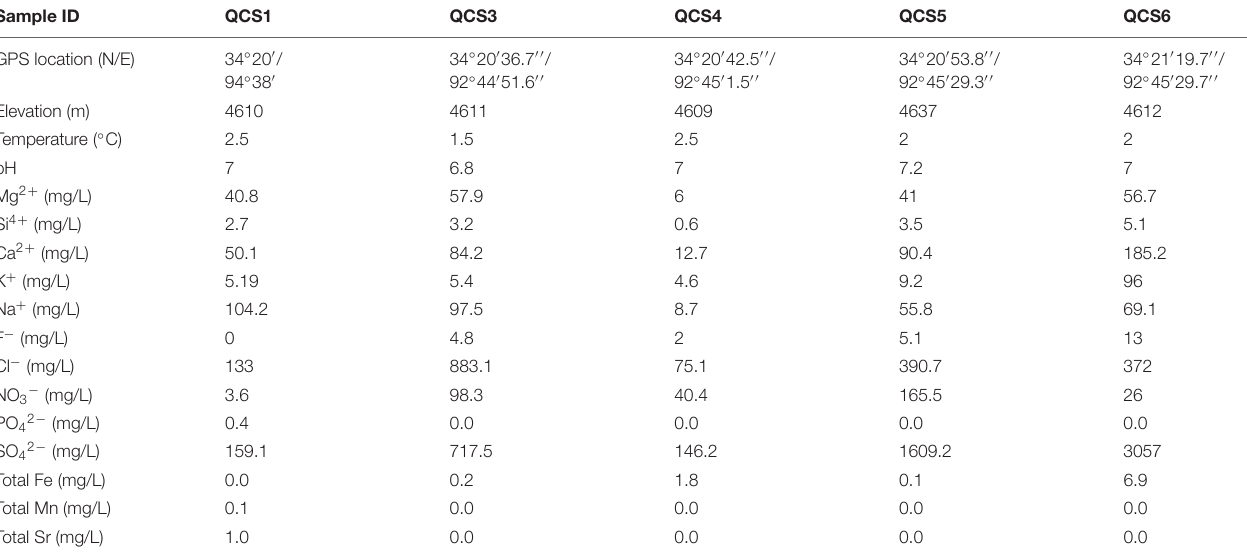
TABLE 1 | Geographic and geochemical parameters of the studied cold springs on the Qinghai-Tibet Plateau.